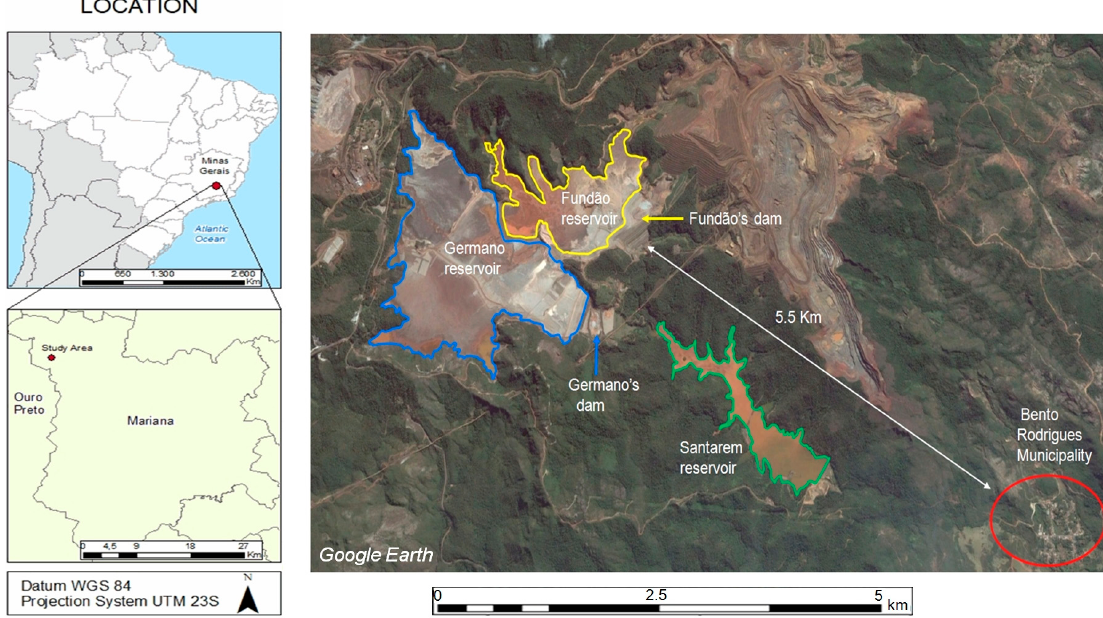
Figure 1. The Germano mining complex location showing the Germano and Fundão tailings dams.